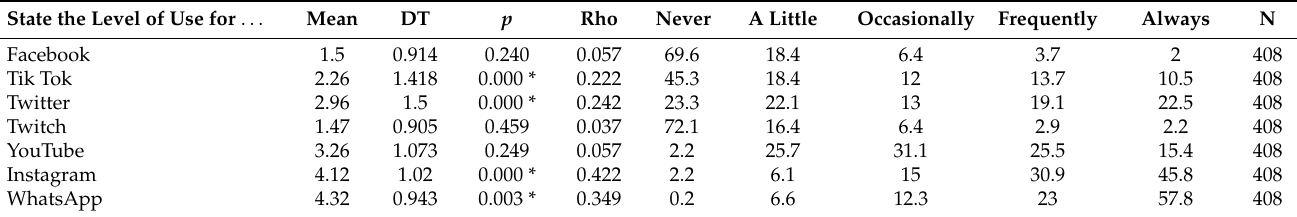
Table 5. Basic statistics for variable (V 6 ) “Define your level of usage for social networks” and correlation with average time of social networks use. Own elaboration. State the Level of Use for . . .